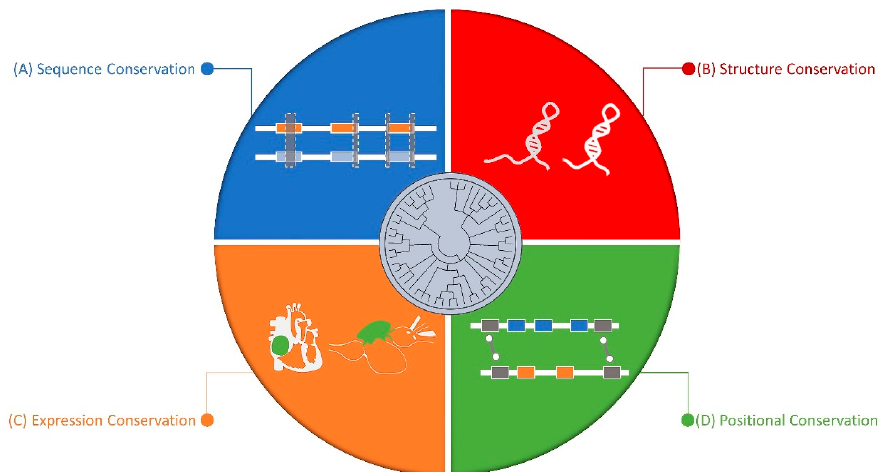
Figure 1. Dimensions of long non-coding RNA (lncRNA) conservation: ( A ) Sequence Conservation: sequence homology or/and conserved gene structures across different organisms. ( B ) Structure Conservation: lncRNAs can form conserved secondary or tertiary structure.